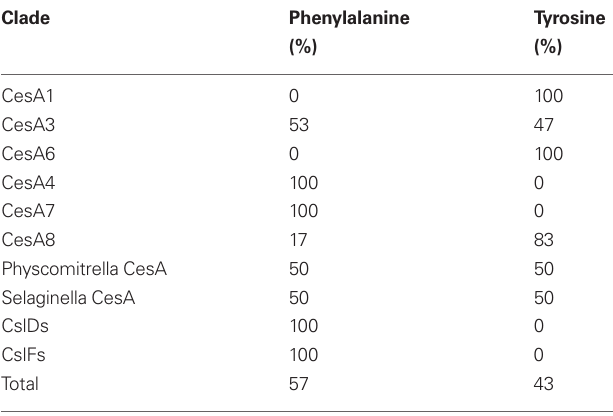
Table 7 | Amino acids observed at second identified aromatic